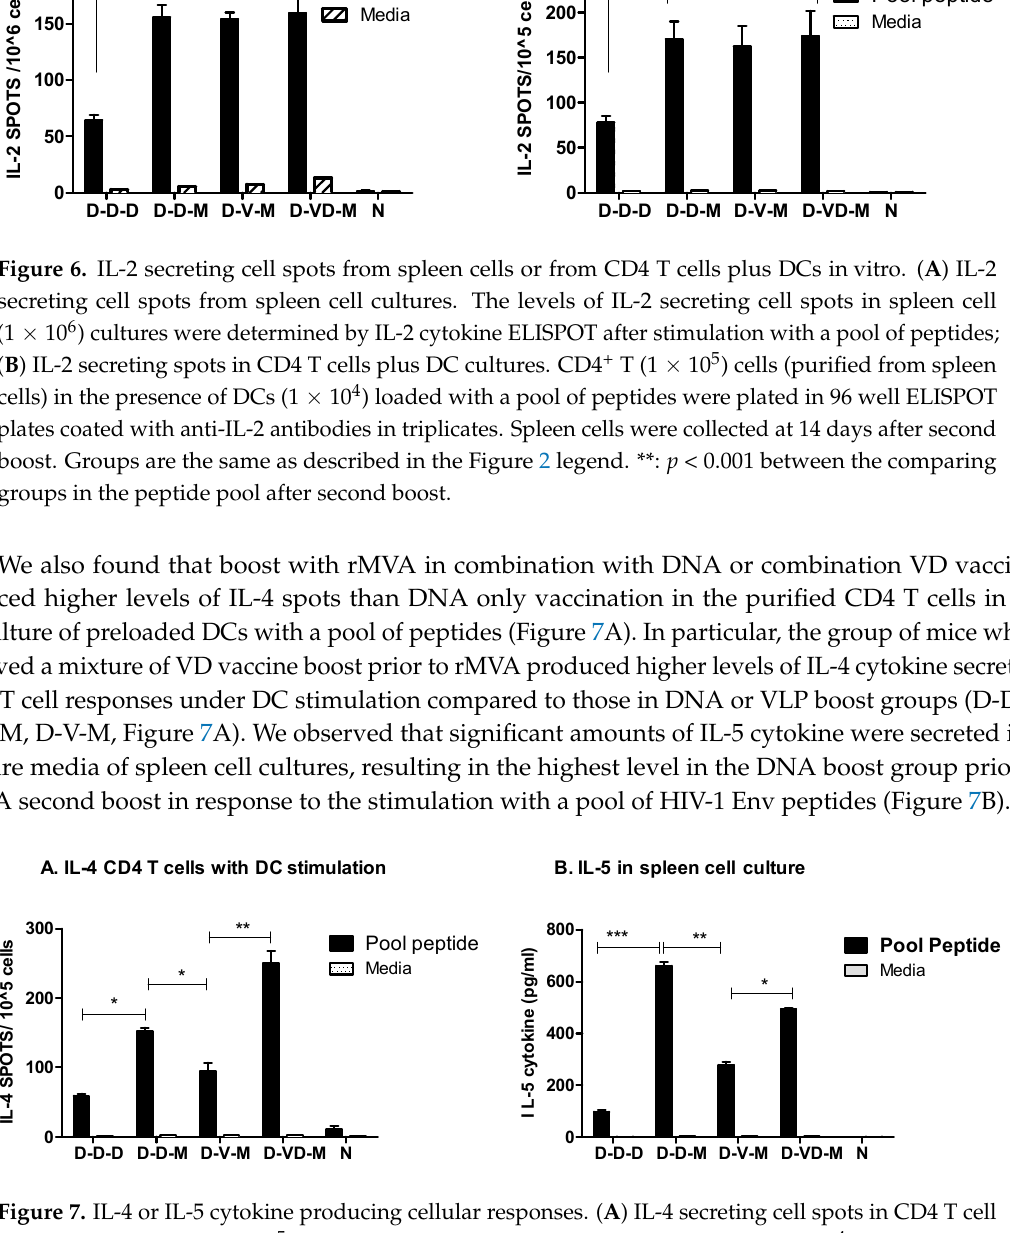
Figure 7. IL-4 or IL-5 cytokine producing cellular responses. ( A ) IL-4 secreting cell spots in CD4 T cell stimulation. CD4 + T (1 × 10 5 ) cells (from spleen cells) in the presence of DCs (1 × 10 4 ) loaded with a pool of peptides were plated in 96-well ELISPOT plates coated with anti-IL-4 antibodies in triplicates; ( B ) IL-5 production from spleen cell cultures. IL-5 cytokine levels in spleen cell (1 × 10 6 ) culture supernatants were determined by using IL-5 cytokine ELISA after stimulation with a pool of peptides. Groups are the same as described in the Figure 2 legend. *: p < 0.05, **: p < 0.001, ***: p < 0.0001 between the comparing groups in the peptide pool after second boost.